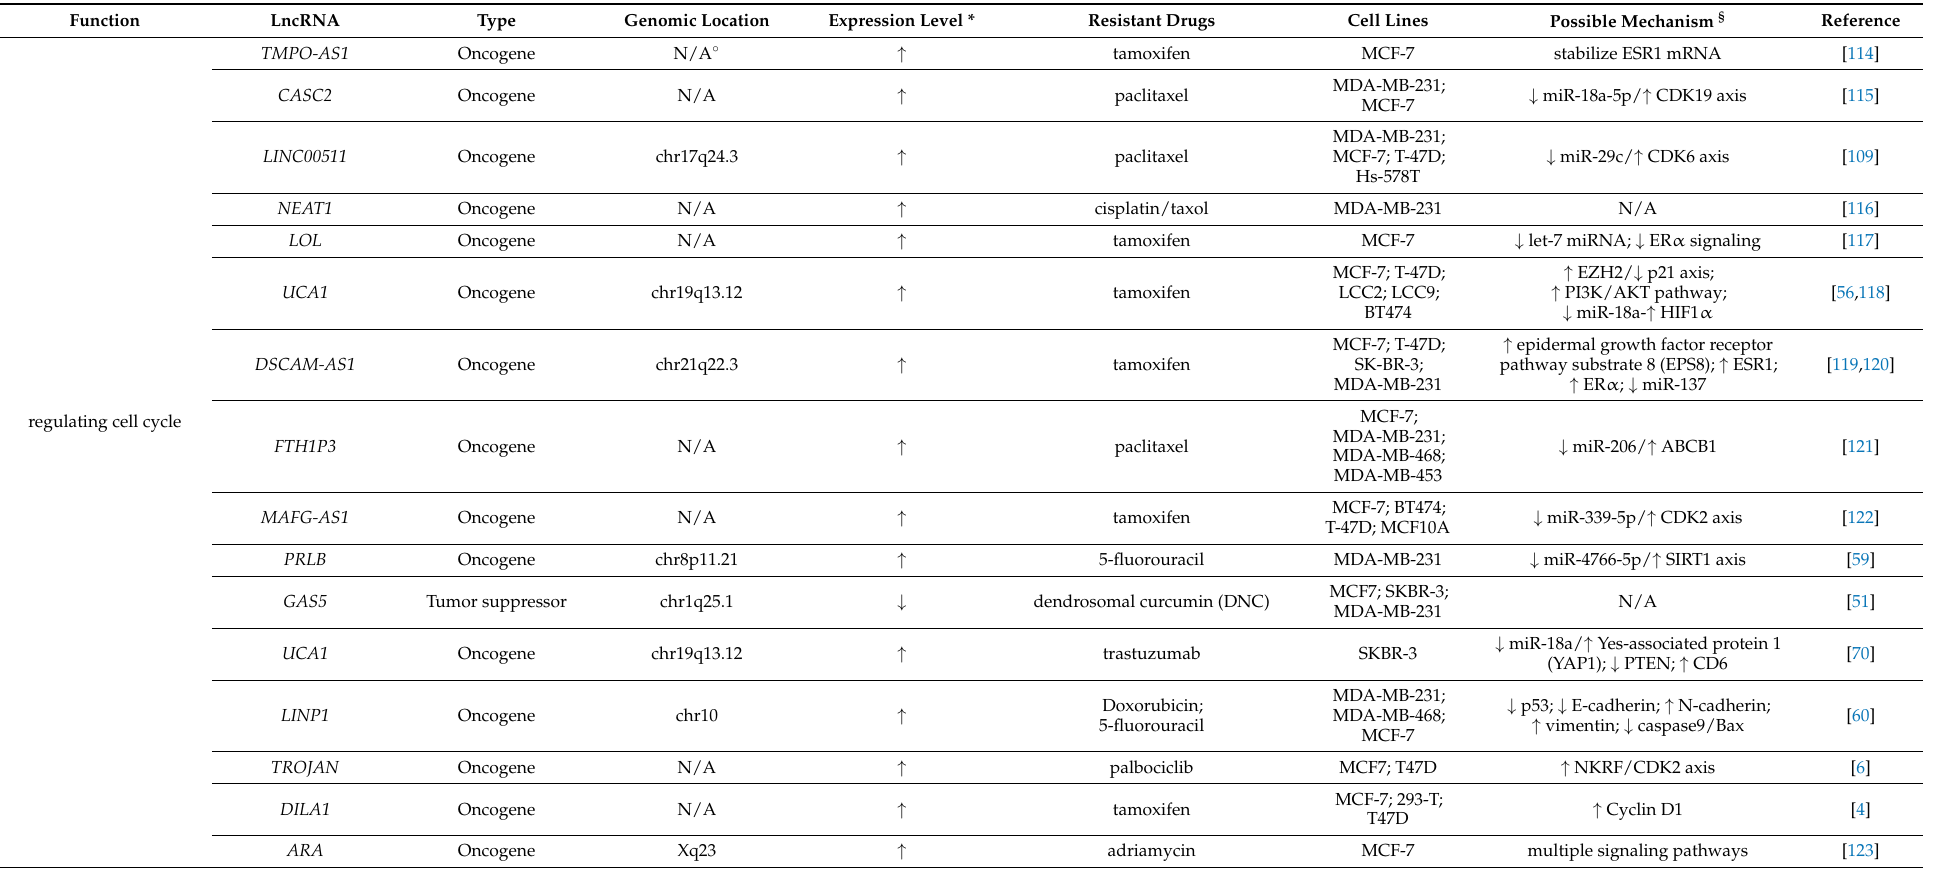
Table 2. The function of lncRNAs in chemoresistance breast cancers, including regulating cell cycle, drug efflux metabolism, EMT and epigenetic